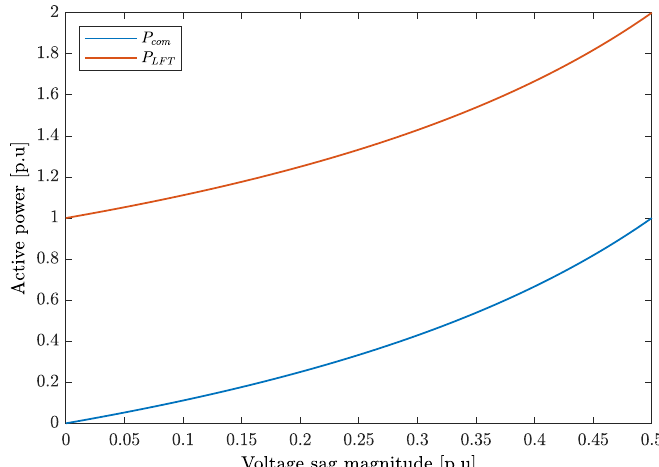
Figure 18. Required circulating active flow values to compensate voltage